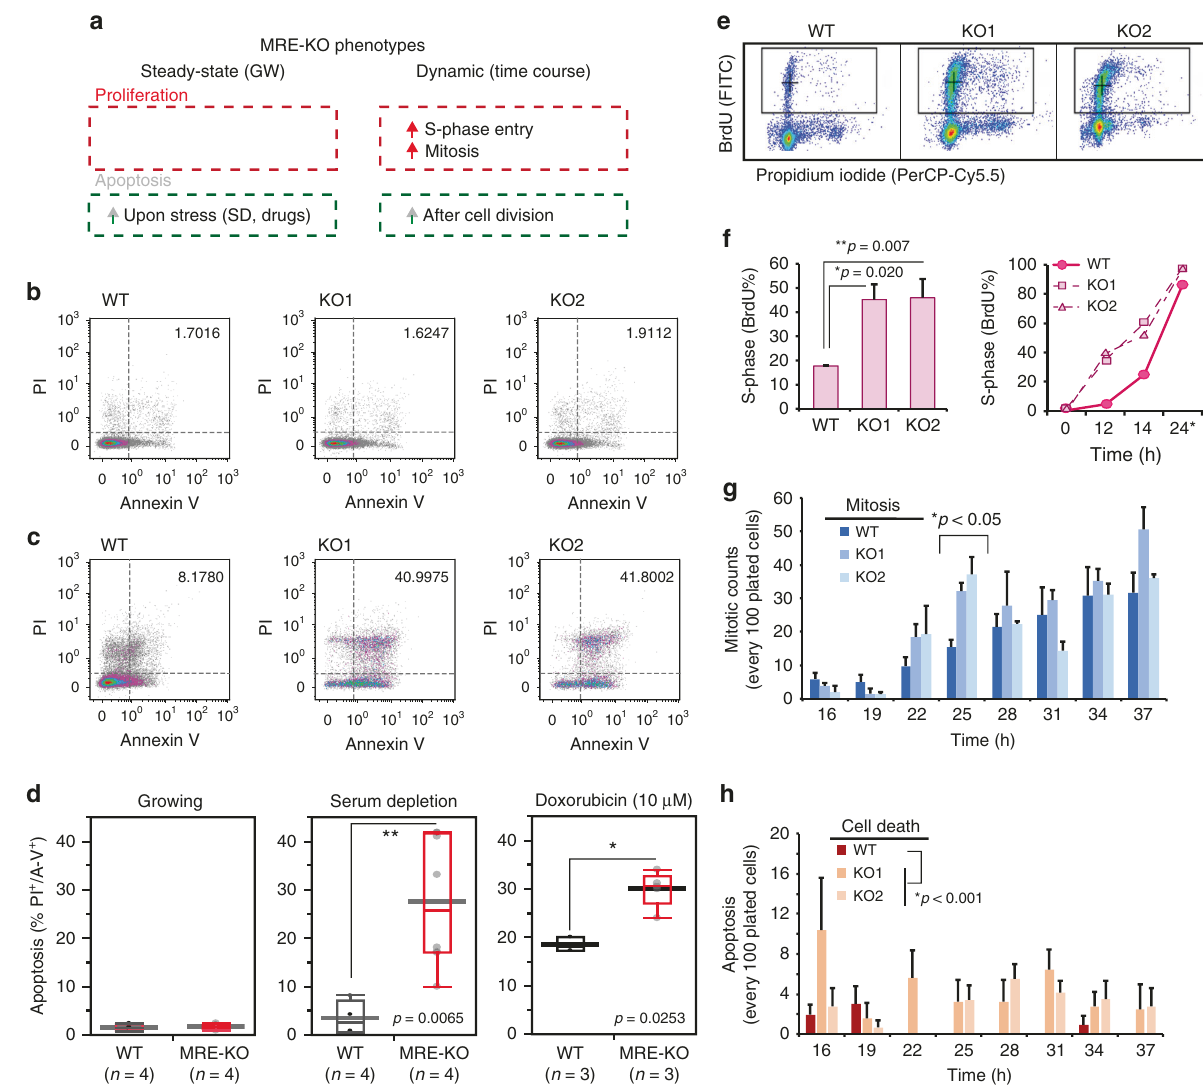
Fig. 6 MRE-KO cells display an altered cell cycle re-entry and are sensitised to apoptosis. a Summary of the phenotypes of MRE-KO cells. b , c Sensitivity to apoptosis was analysed in MRE-KO clones and WT cells by FACS pro fi ling; apoptotic cells were identi fi ed by propidium iodide (PI) and Annexin-V staining; b asynchronously growing condition; c cells were serum depleted for 48 h. d Box-plots of apoptotic cells (PI + and Annexin-V + ) in WT and MRE-KO clones in different conditions. Asterisks mark signi fi cant values (* p < 0.05, ** p < 0.01, Wilcoxon test). e Dynamics of cell cycle re-entry induced by serum stimulation by FACS analysis. S-phase entry was determined by BrdU incorporation (30 min pulse) and propidium iodide staining. f Left: S-phase entry evaluated at 14 h post – serum stimulation (average and s.e.m.; n = 3). Right: line chart shows a single time course of cell cycle re-entry (24*: cells treated in continuous with BrdU for 12 h). g , h Number of mitosis ( g ) and cell deaths ( h ), normalised for every 100 plated cells, occurring between 16 and 37 h after serum stimulation as analysed by time-lapse microscopy ( n = 3). f , g , h p -value by Welch ’ s